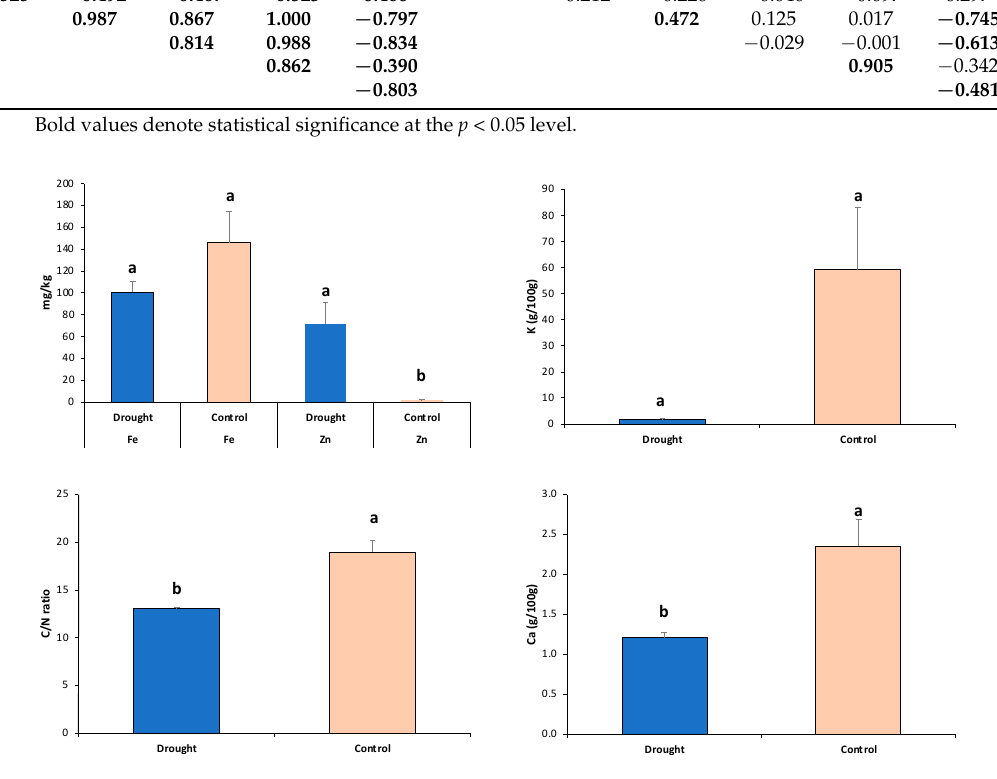
Figure 7. Effects of normal irrigation control vs. drought treatments on the C/N balance and leaf nutrient concentrations (Ca, Fe, K, and Zn) across the fi ve grain legumes. Di ff erent le tt ers indicate signi fi cant di ff erences between treatments for the genotypes of the fi ve grain legume species at p < 0.05 by Tukey’s HSD test. Each bar represents mean + SE (standard error).